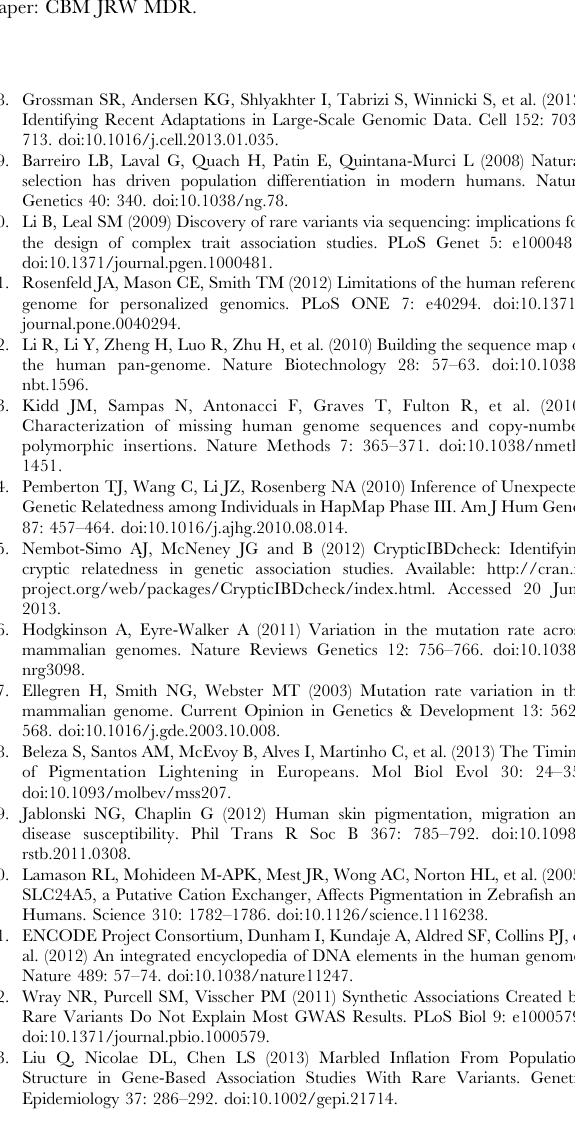
Table S3 Specific genes of interest with known allele frequency differences between ancestral populations. Table S4 Example of BioBin parameter options, rare-case- control (RCC) and overall-major-allele (OMA). Table S4 contains iterations of major/minor allele selection and variant binning using new parameters rare-case-control (RCC) and overall-major- allele (OMA). Using both options is necessary to make the results independent of control group selection. Table S5 Excerpt of custom region file containing regions with signatures of natural selection.